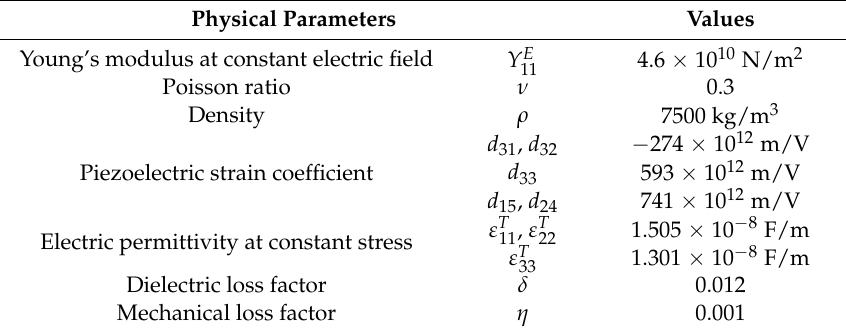
Table 1. Material properties of the PZT patch used in the numerical